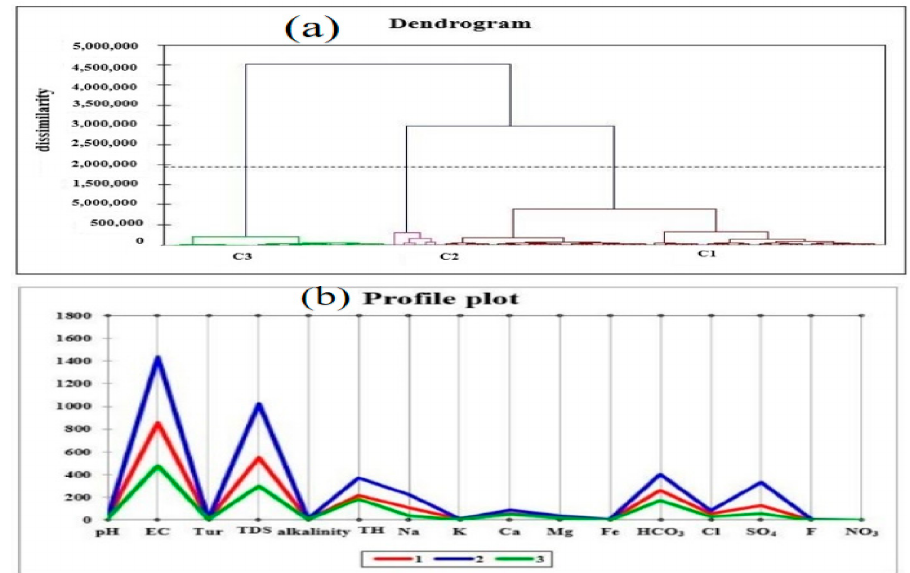
Figure 9. ( a ) Clustering of groundwater samples based on dissimilarity. ( b ) Groundwater